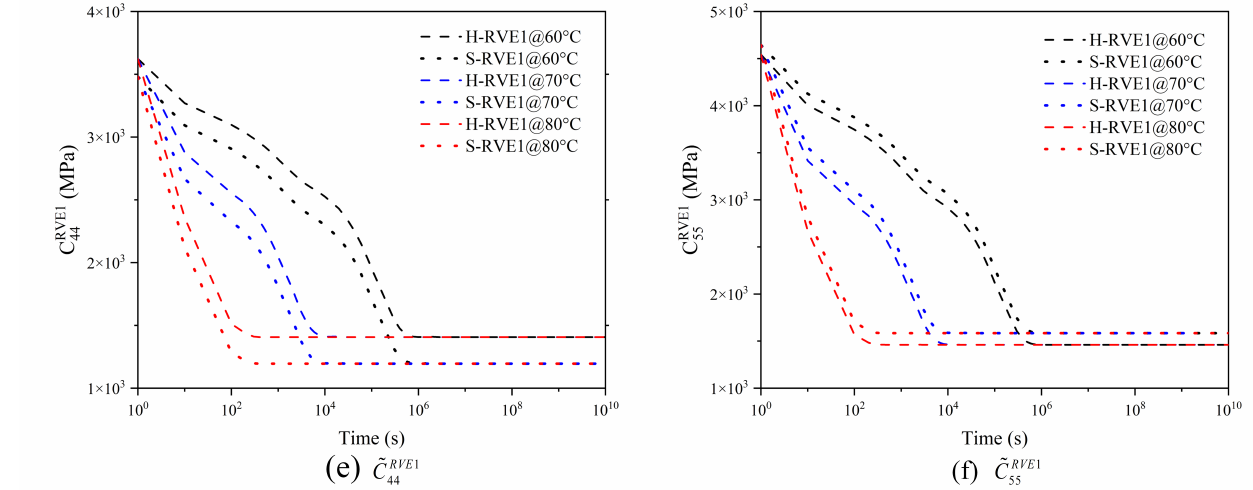
Figure 8.Figure 8. Effect of temperature on the effective relaxation stiffness of the yarn.